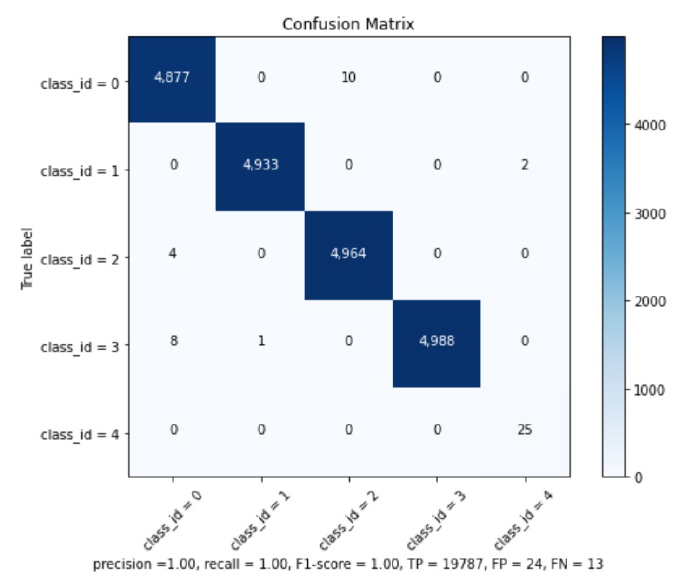
Figure 13. Confusion Matrix.